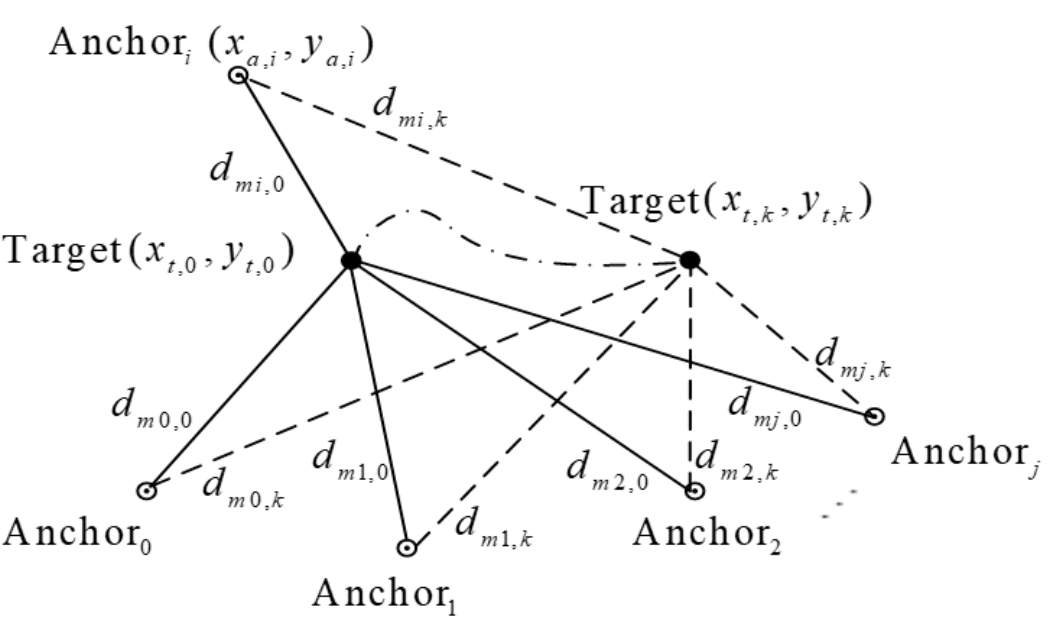
Figure 2. Positioning Process.